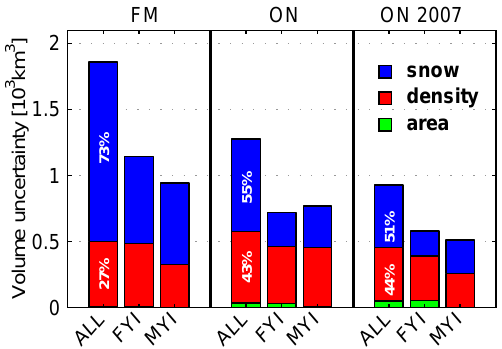
Fig. 9. Absolute uncertainties in Arctic sea ice volume. Contri- butions from uncertainties in sea ice density, snow depth, and sea ice area are included and given for the the mean in Febru- ary/March (FM) and October/November (ON). Additionally, Octo- ber/November 2007 (ON07) is shown separately. Note that the dis- tributions of sea ice density and snow depth are non-Gaussian for the total sea ice (see PDFs in Fig. 2) and therefore the contributions from the three parameters over first-year ice (FYI) and multi-year ice (MYI) do not sum up for the total sea ice volume